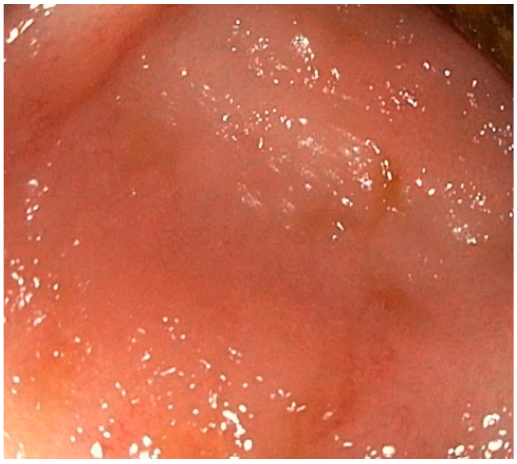
Figure 3. Sigmoidoscopy image of COVID-19 colitis after recovery.